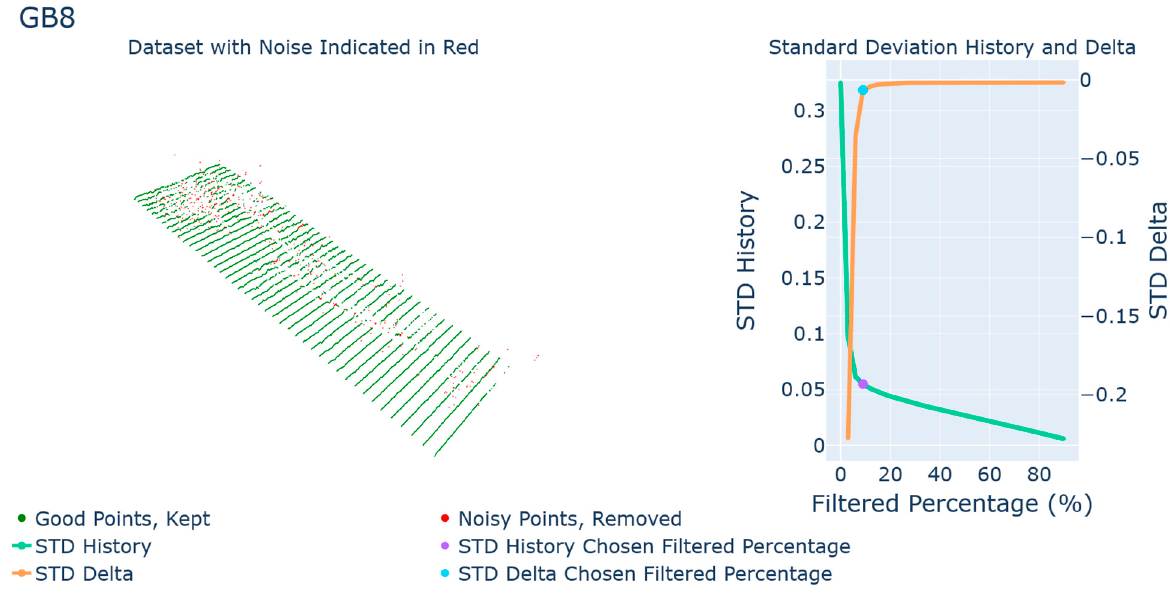
Figure 8. Results for gauge block at +10°.